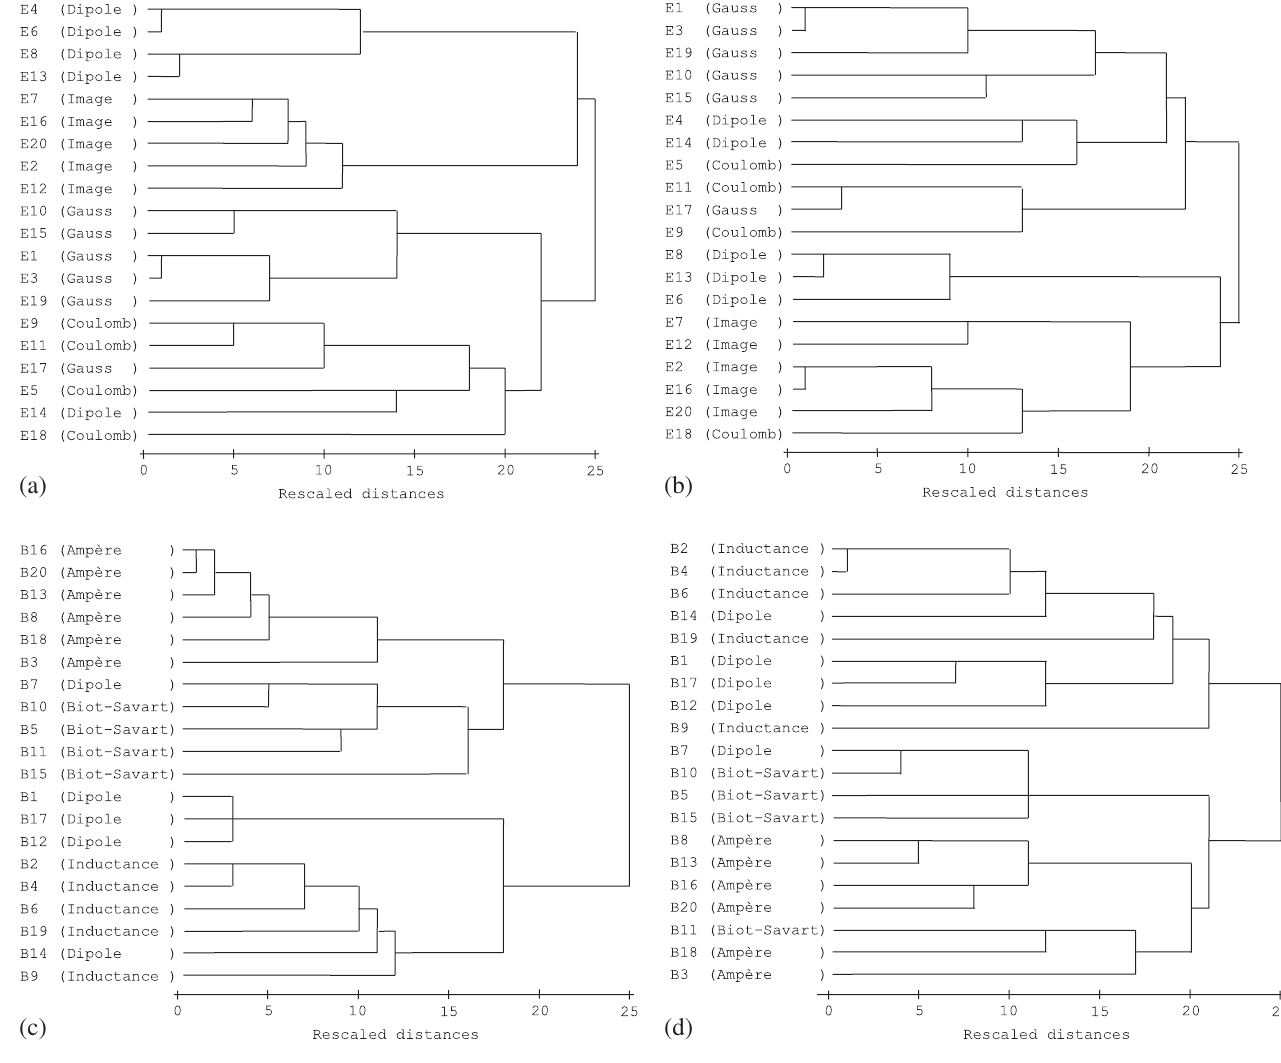
FIG. 1. (a) Cluster analysis, electricity, proficient students ( n ¼ 19 ). (b) Cluster analysis, electricity, less proficient students ( n ¼ 16 ). (c) Cluster analysis, magnetism, proficient students ( n ¼ 17 ). (d) Cluster analysis, magnetism, less proficient students ( n ¼ 19